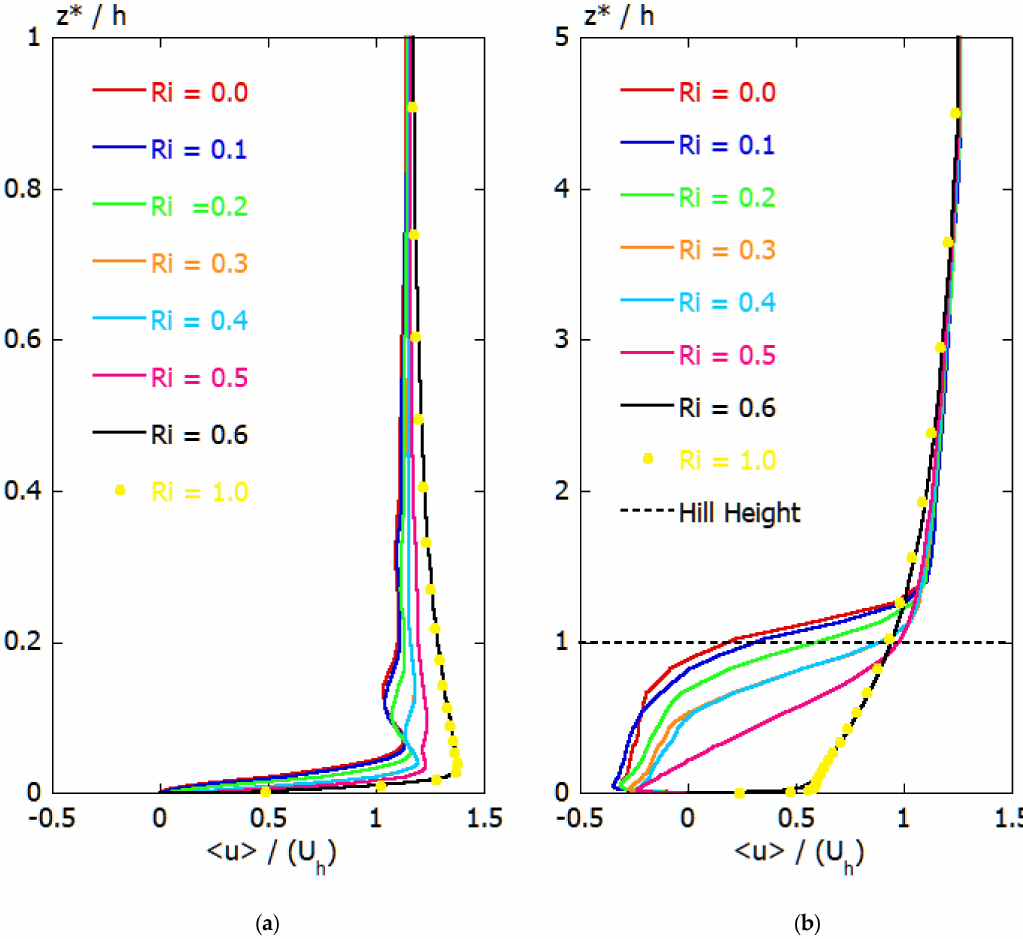
Figure 12. Comparison of time-averaged U-velocities under various stable conditions in the steep hill scenario. ( a ) x = 0 h (hilltop); ( b ) x = 2 h (behind the